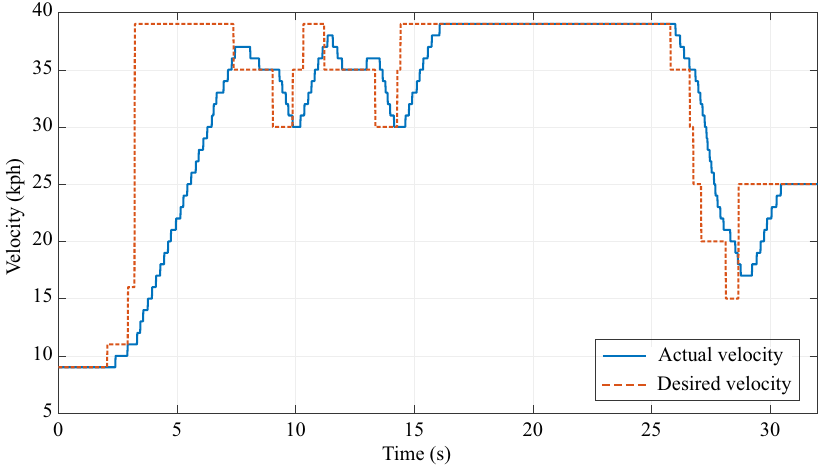
Figure 15. Velocity tracking of our SFF-PI controller, where the time is counted from the beginning of data